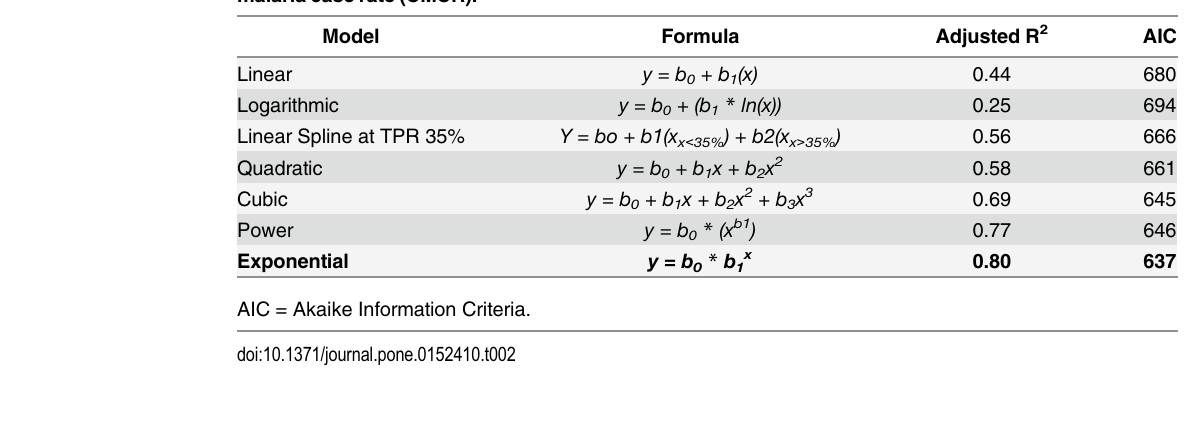
Table 2. Regression models of diagnostic test positivity rates (TPR) as predictors of confirmed malaria case rate